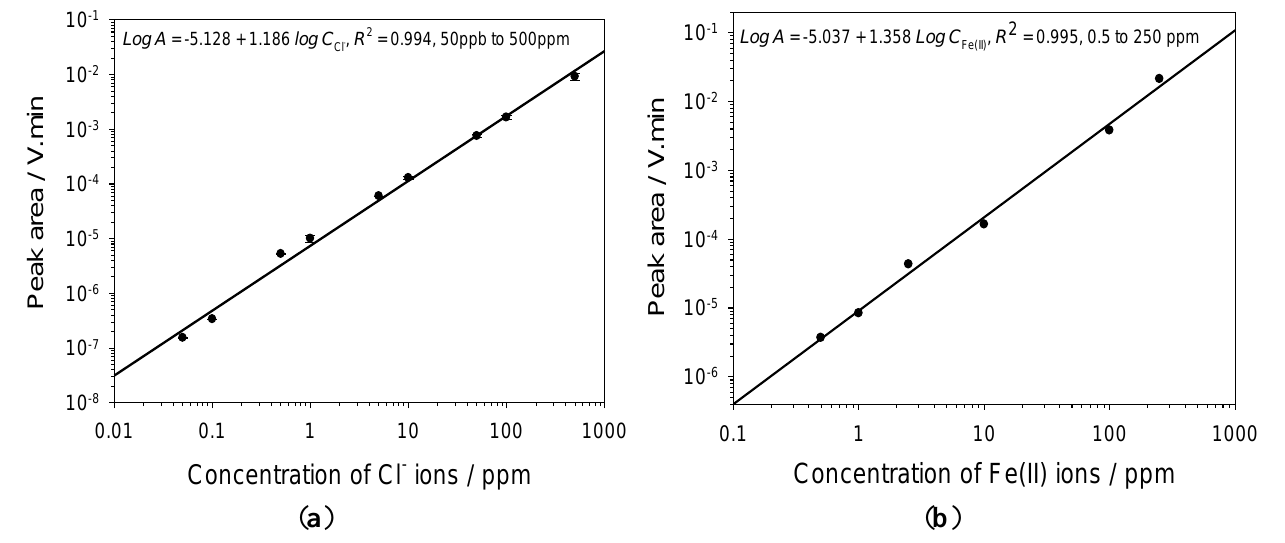
Figure 4. ( a ) Calibration curves for chloride ions; and ( b ) ferrous ions obtained under optimised